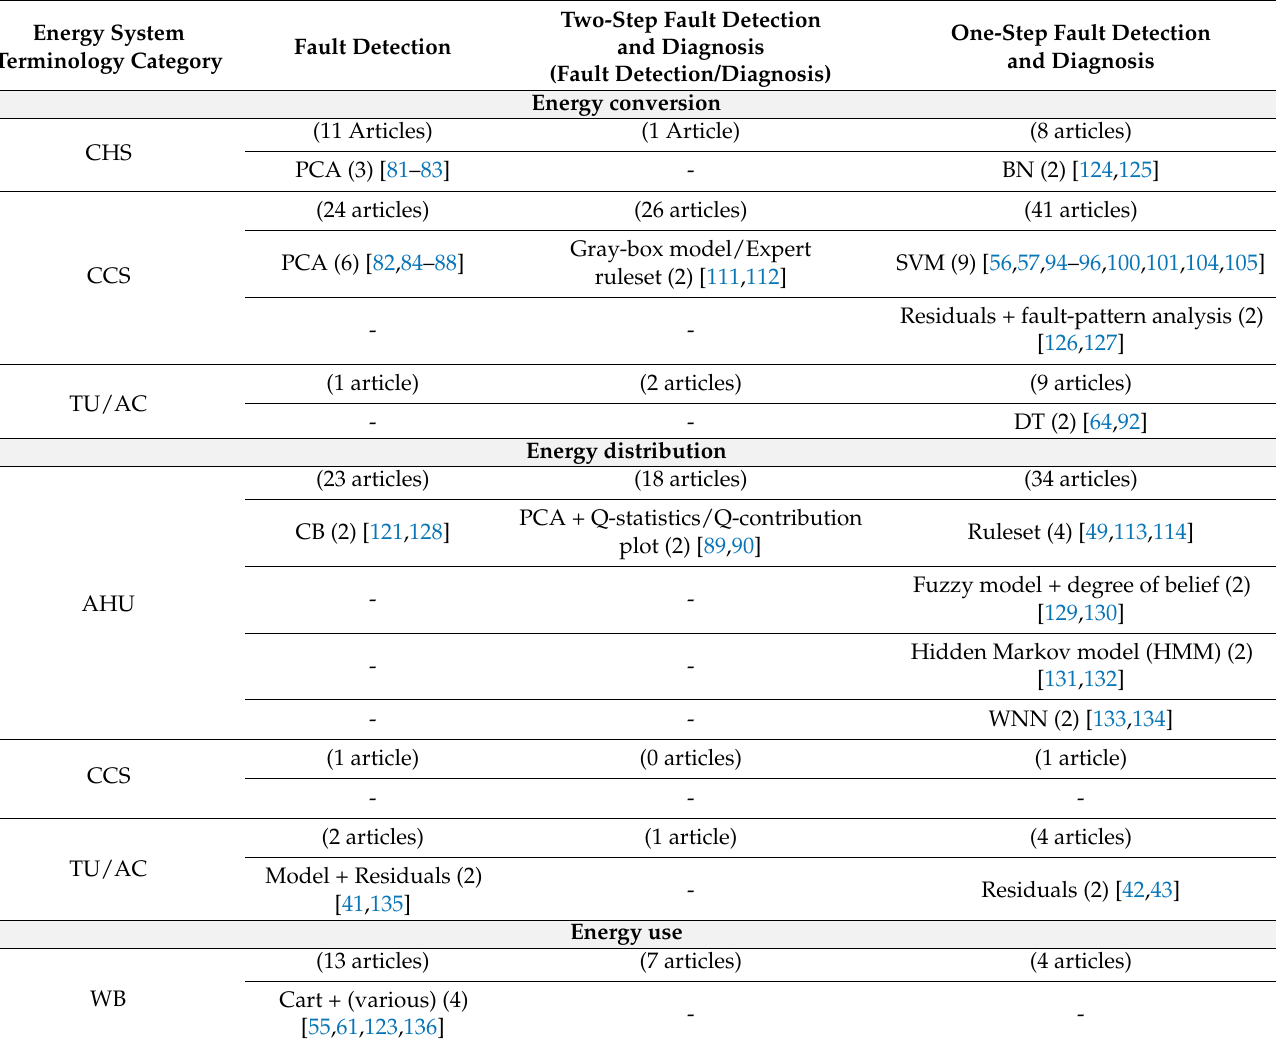
Table 7. FD and one- and two-step FDD algorithms divided by the EST groups. Fields indicated with (-) mean that no trend was